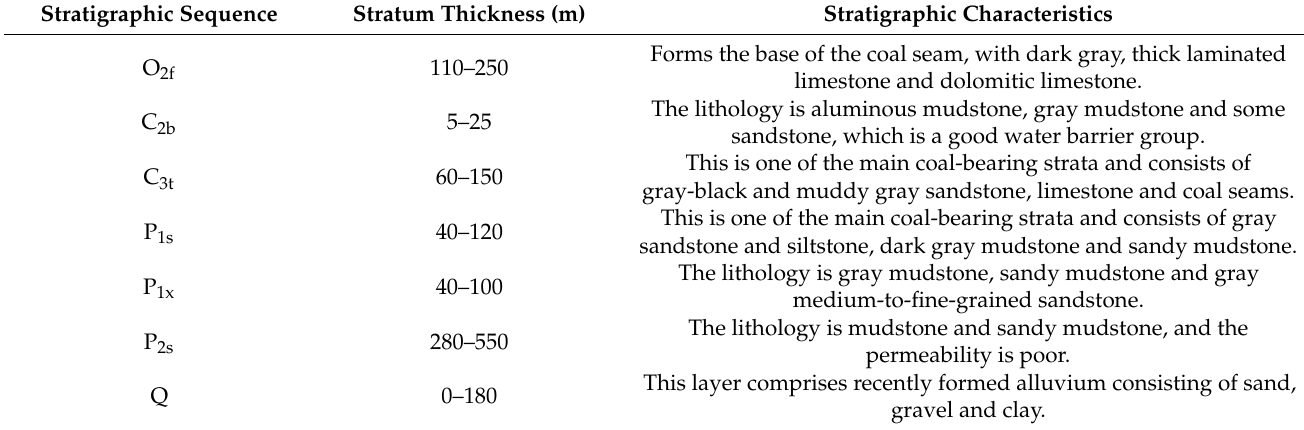
Figure 1. Geographical location and distribution of mining area. Table 1. Stratigraphic information of the study